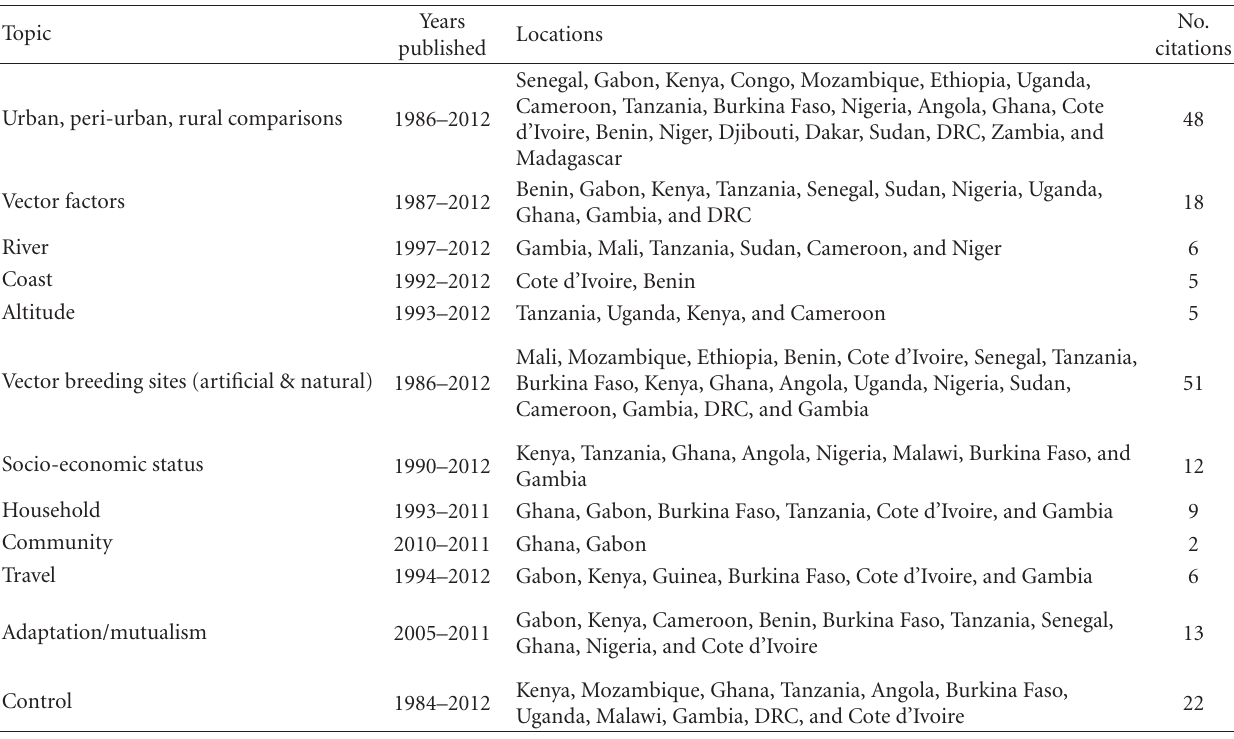
Table 1: Summary of results by year, location, and number of